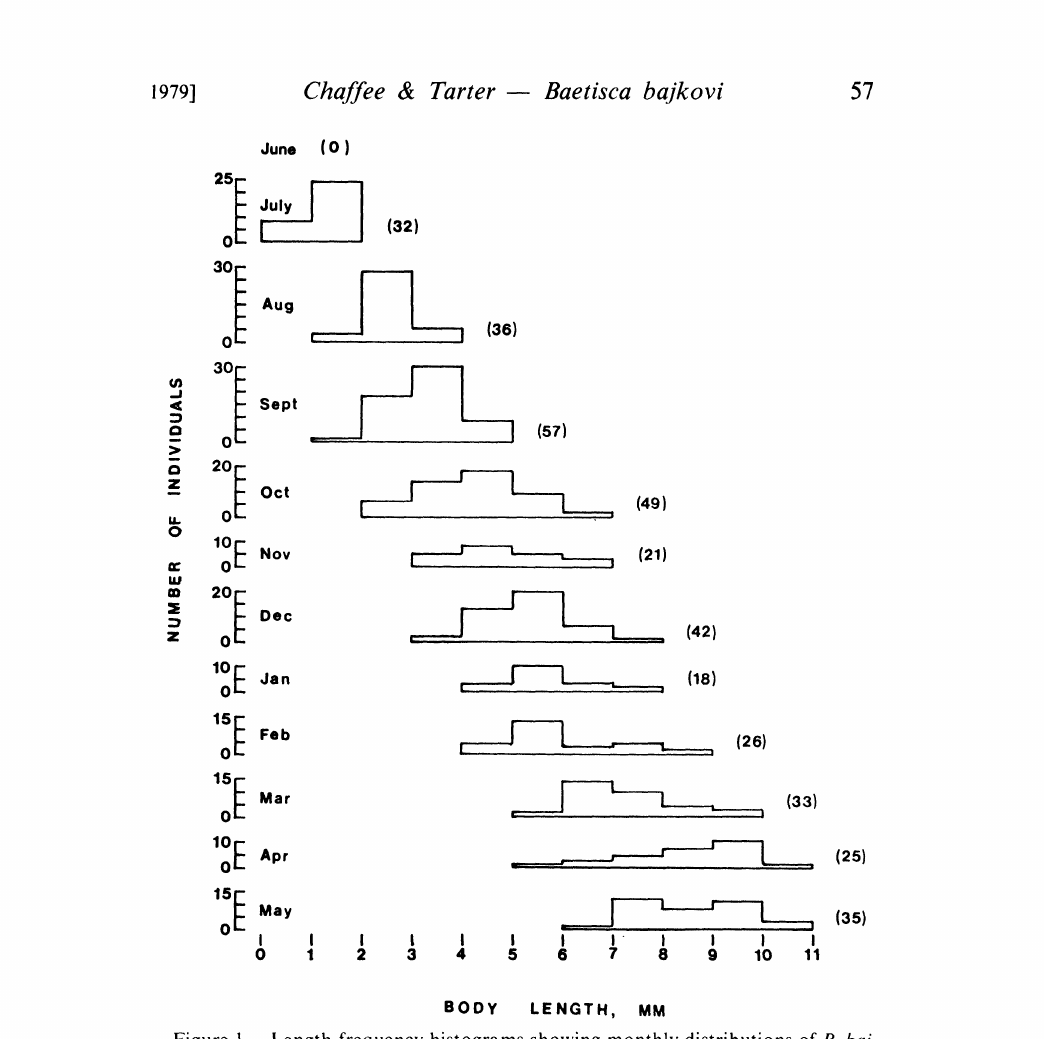
Figure 1. Length-frequency histograms showing monthly distributions of B. ba/- kovi nymphs, Beech Fork of Twelvepole Creek, Wayne County, West Virginia, 1976-77. Number of individuals collected each month is given in